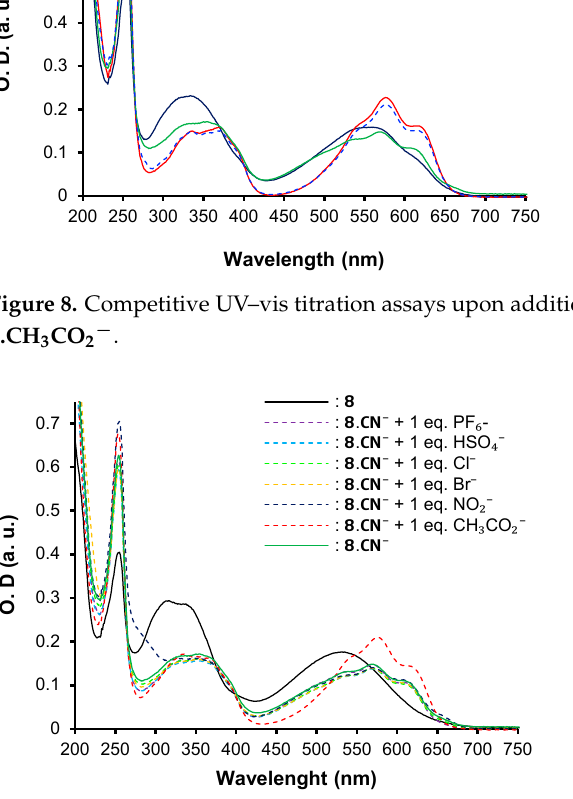
Figure 9. Competitive UV–vis titration assays upon addition of 1 equivalent of competitive anions to 8.CN − .